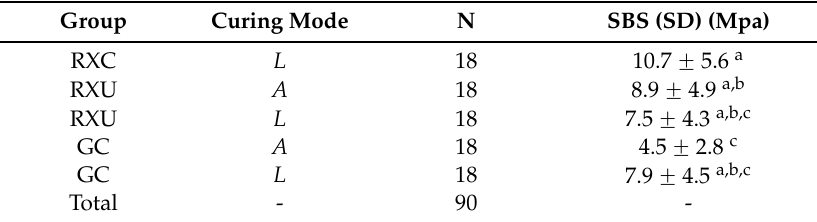
Table 2. Mean shear bond strength (MPa) and descriptive statistics according to different cements and curing mode.